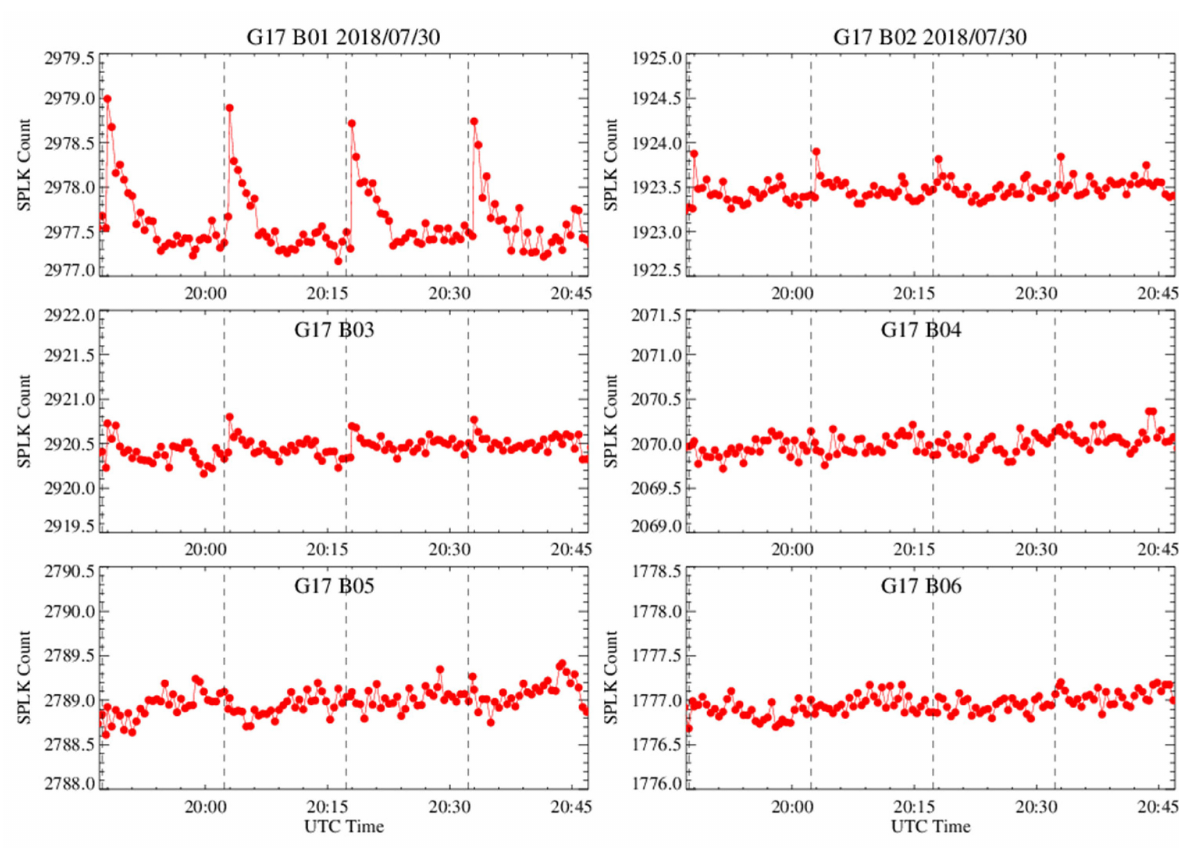
Figure 11. As Figure 10, but for G17 on 30 July 2018.